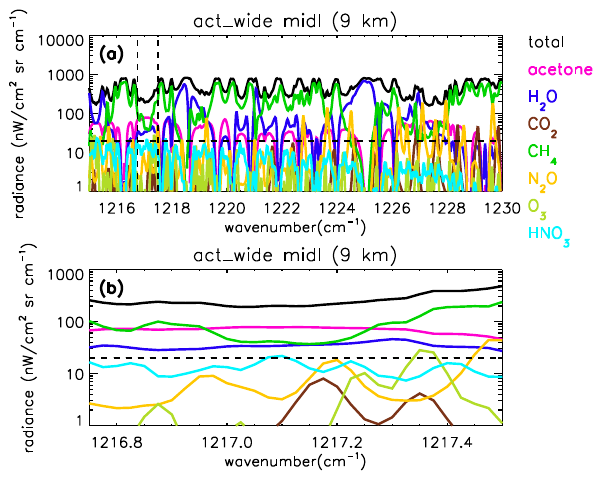
Fig. 1. Plot of modelled radiance contributions for the radia- tively active gases in (a) the 1215 cm − 1 to 1230 cm − 1 range and (b) 1216.75 cm − 1 to 1217.5 cm − 1 in the mid-latitudes (20 ◦ to 65 ◦ ). The dotted line represents the noise equivalent spectral radiance (NESR) of 20 nW/(cm 2 sr cm − 1 ) as reported in MIPAS band–B by Kleinert et al. (2007).